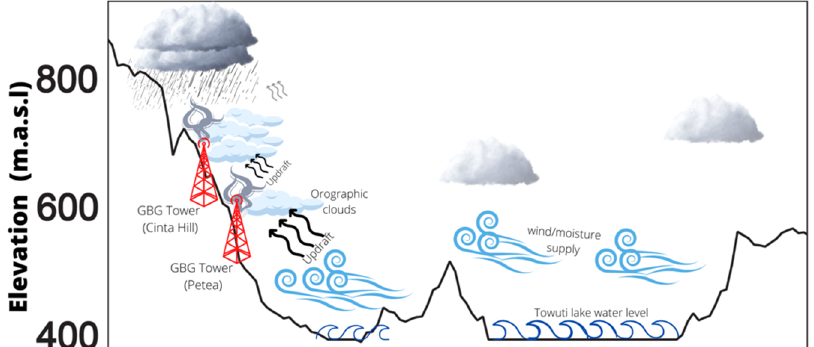
Figure 5. Schematic diagram of hygroscopic ground-based cloud seeding over Larona Basin. The wind regime will bring moisture from the lake water bodies into hills/mountains in the northern and western areas. Flares in the GBG towers will add CCN into newly developed orographic clouds, and enhance the precipitation process inside the cloud, changing cloud droplets into rain droplets.